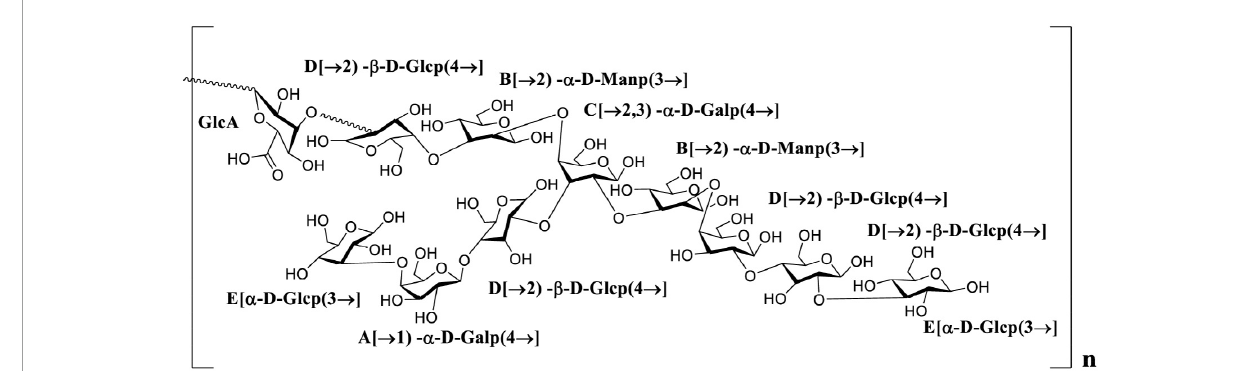
FIGURE5 The putative structure of PKP2-1.